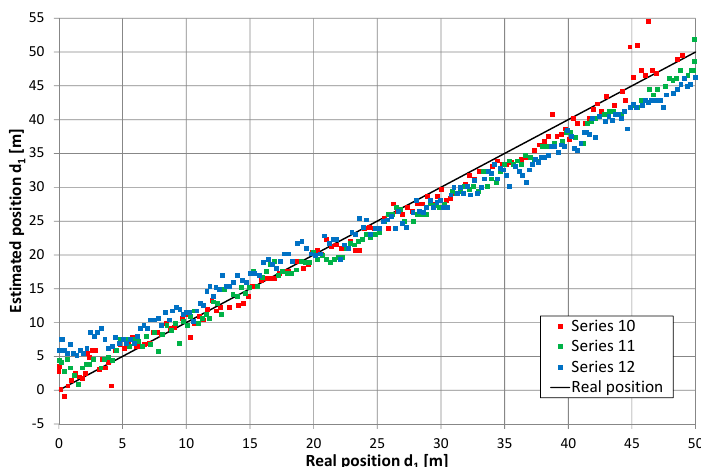
Figure 14. Results of position estimation in the case of return signal frequency conversion; the height of receiving antenna: 1 m, series 10–12.